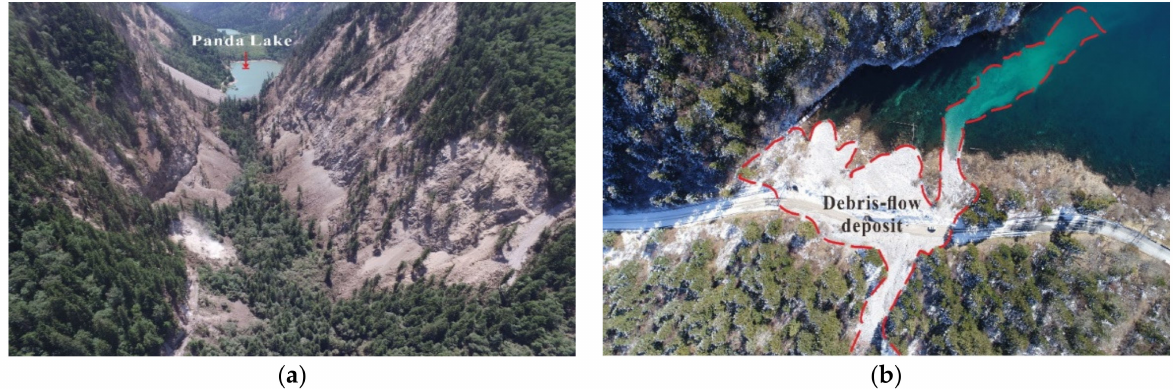
Figure 3. Geohazards caused by the Jiuzhaigou earthquake and their impact on the vegetation. ( a ) Panda Lake and coseismic landslides; ( b ) Xiajijiehai Lake and debris-flow